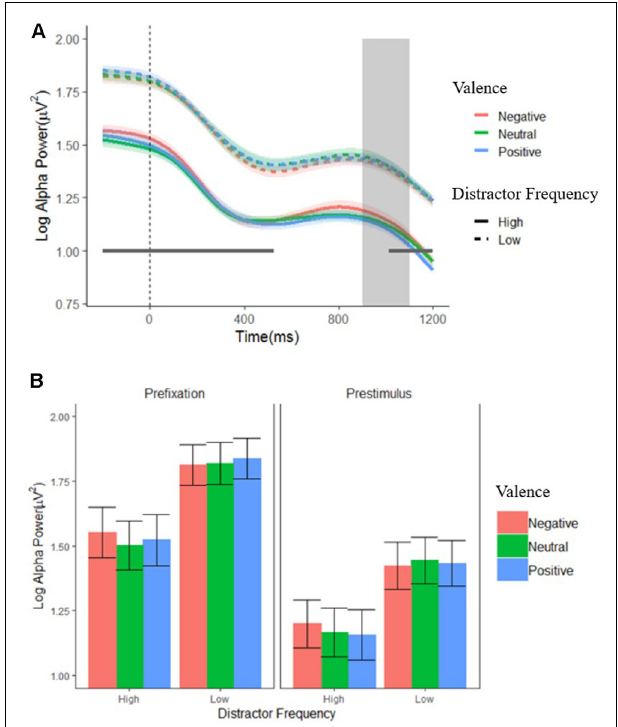
FIGURE 3 | Log alpha power. (A) Grand average waveforms of log-transformed individual alpha frequency (IAF) alpha power from pooled electrodes 01, 02, and 0Z in the low (dashed lines) and high (solid lines) distractor frequency conditions, according to valence block. Fixation onset occurs at 0 ms. The gray box indicates the period when a stimulus display could occur (900–1,100 ms). The gray horizontal line indicates where alpha power was significantly reduced in the high compared to low distractor frequency condition. Shaded error bars depict the ± 95% within-subjects confidence intervals. (B) Average alpha power during the pre-fixation ( − 200 to 0 ms) and pre-stimulus (700–900 ms) time windows. Error bars depict the between-subjects SEM.